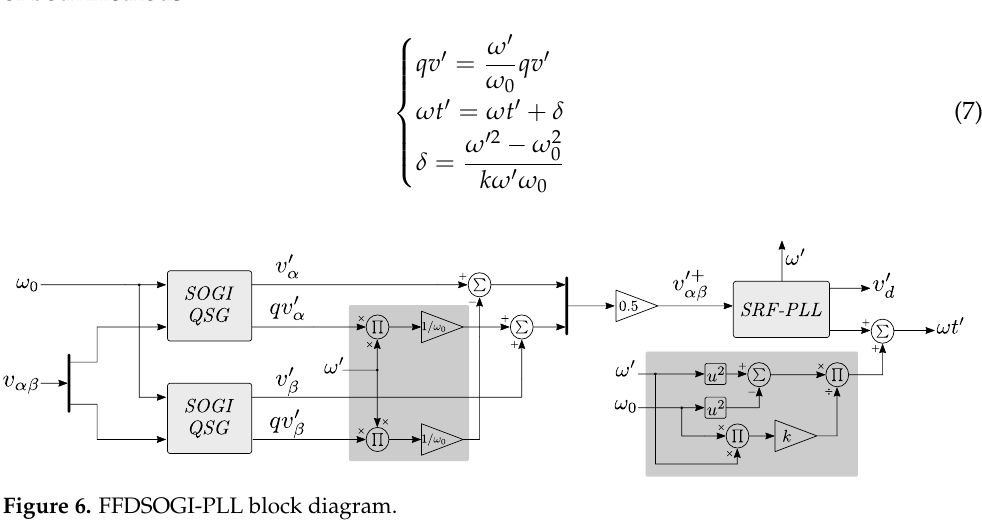
Figure 6. FFDSOGI-PLL block